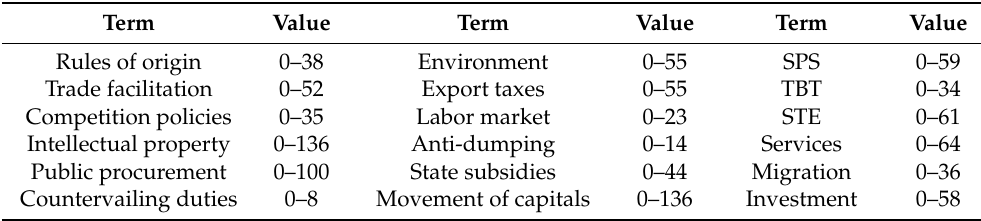
Table 1. Value of